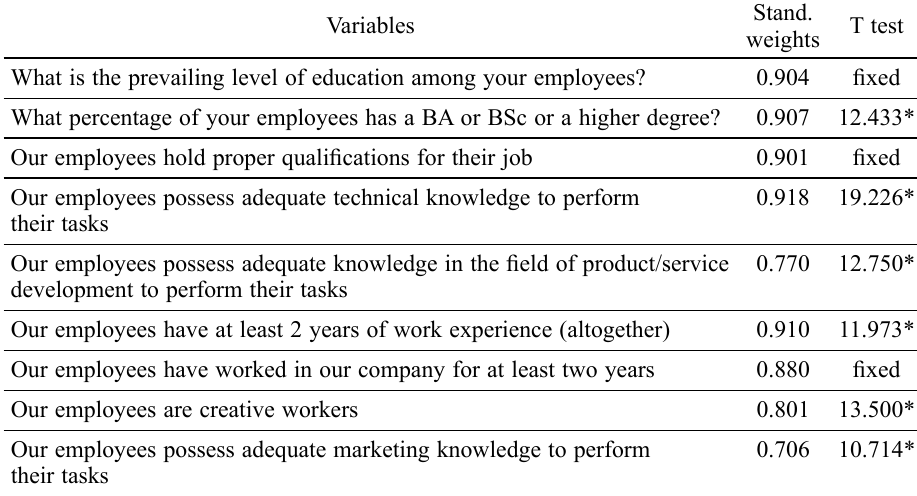
Table 5. Standardised coefficients